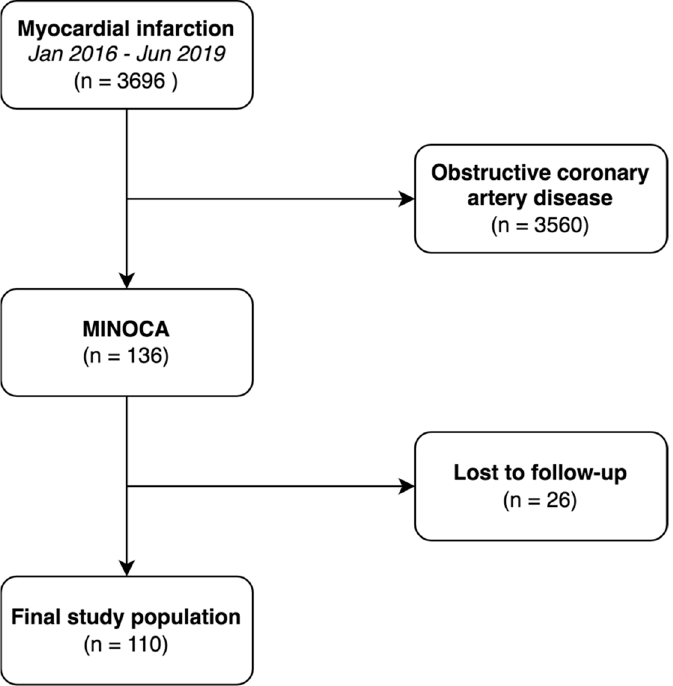
Figure 1. Flowchart of the study. Abbreviations: MINOCA—myocardial infarction and non- obstructive coronary arteries.